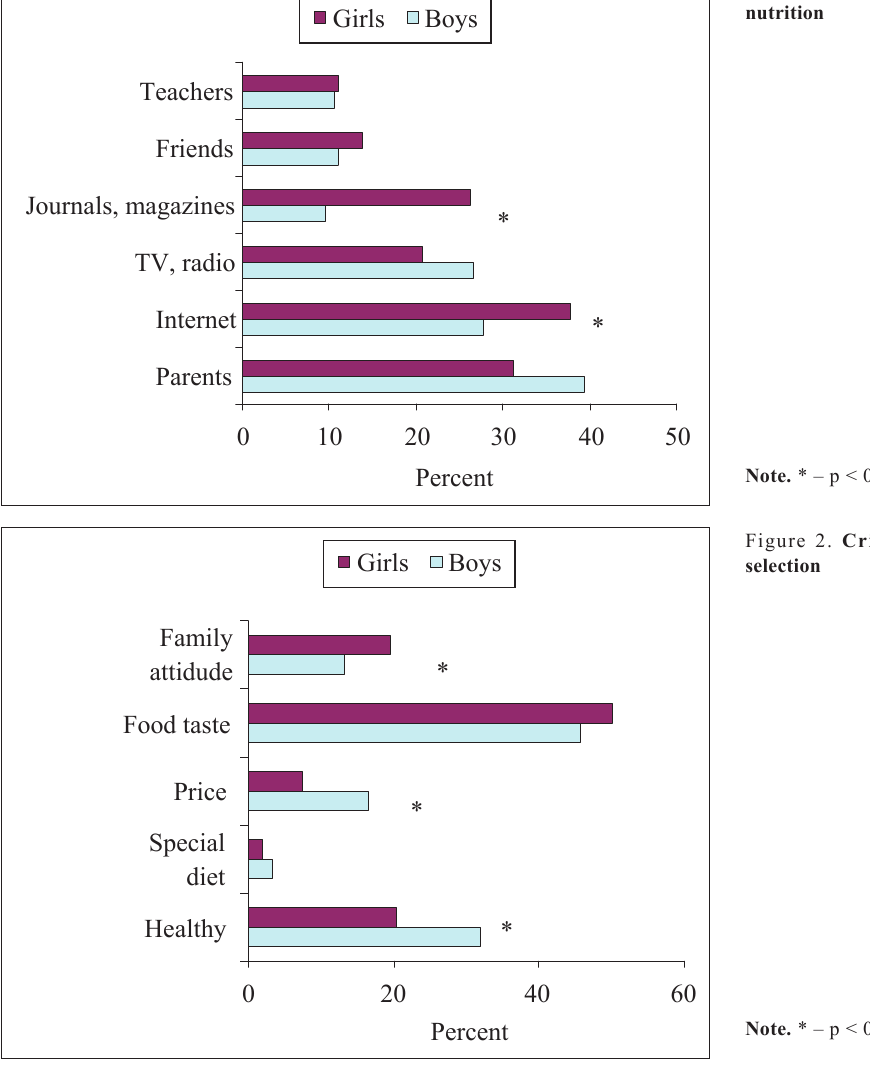
Figure 1. Sources of information about healthy nutrition